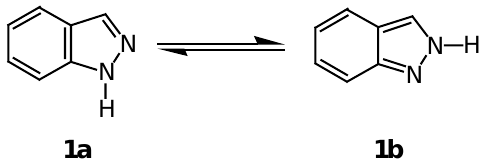
Figure 1. Annular tautomerism of indazole ( 1a : benzenoid 1 H -indazole tautomer; 1b : quinonoid 2 H -indazole